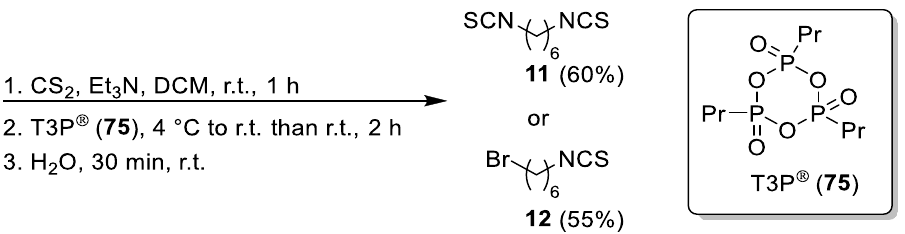
Scheme 3. Method C: synthesis of isothiocyanate derivatives of methyl ester amino acids 7 – 9 using DMT/NMM/TsO − ( 74 ) as desulfurating reagent.